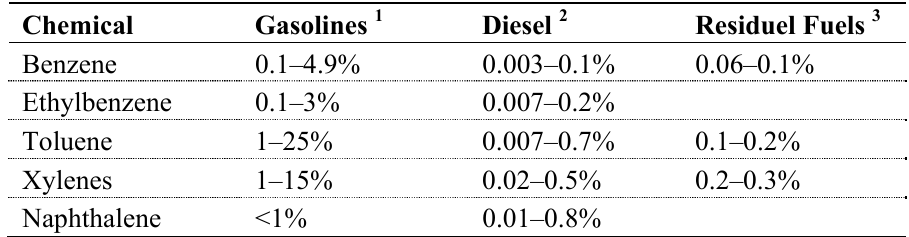
Table 1. Range of current and past BTEX and naphthalene (BTEXN) concentrations in petroleum